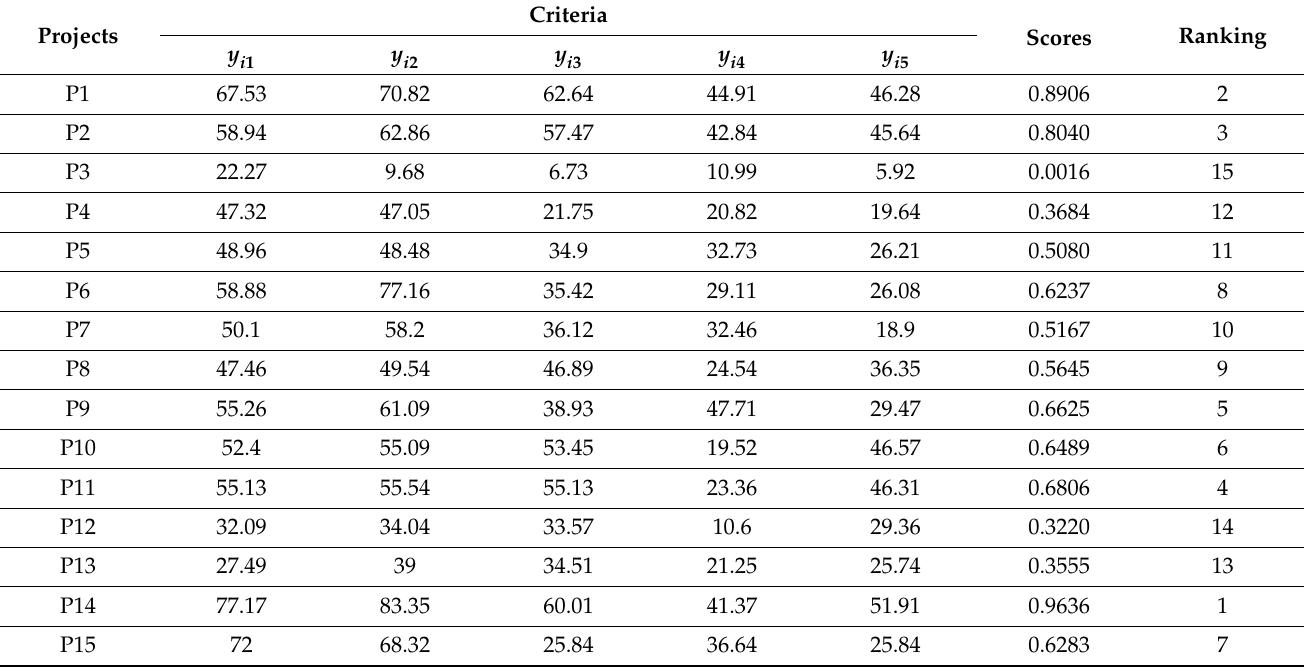
Table 2. Multiple criteria PPP